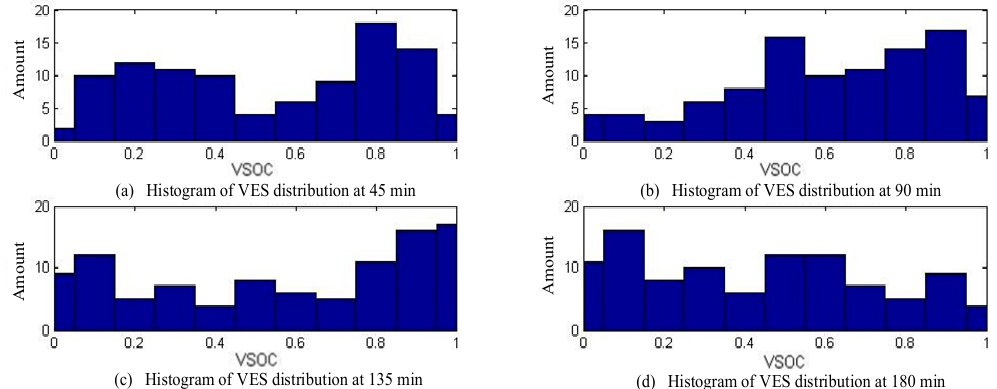
Figure 13. Histograms of VES distribution at different time points (after optimized).